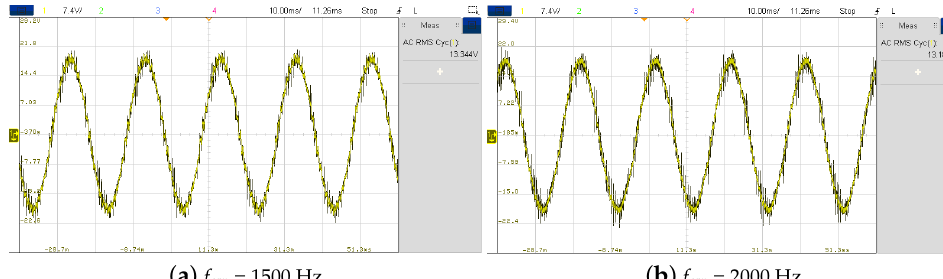
Figure 21. Phase Voltage SVM.